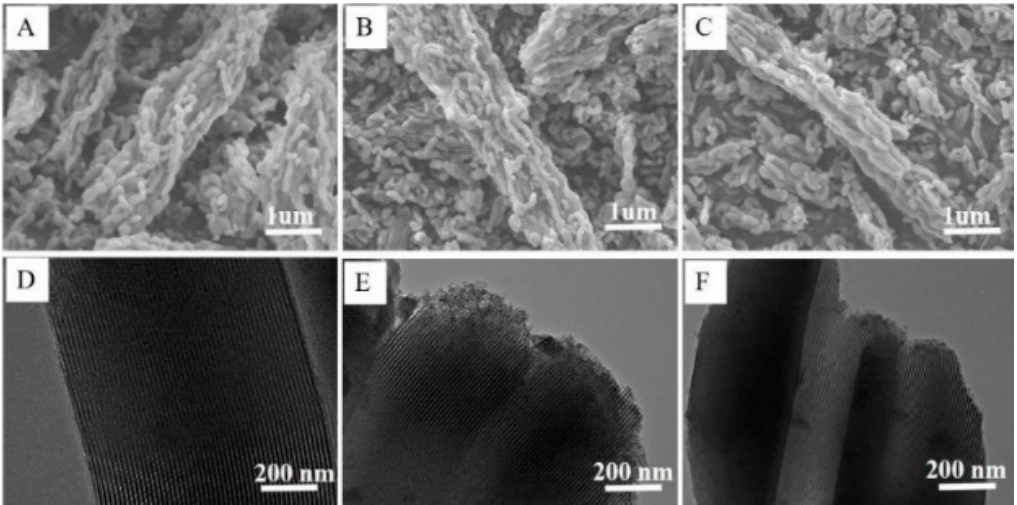
Figure 3. SEM and TEM images of SBA ‐ 15 ( A , D ), meso ‐ Pr ‐ SO 3 H ‐ SBA ‐ 15 ( B , E ) and meso ‐ Ph ‐ SO 3 H ‐ SBA ‐ 15 ( C , F ) samples.